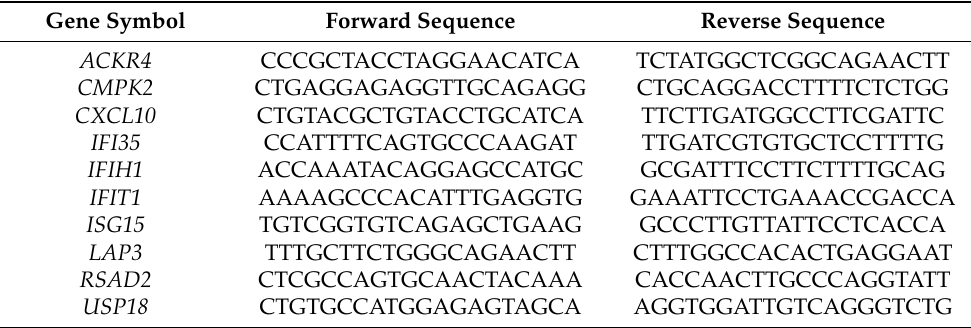
Table 4. Primers used in